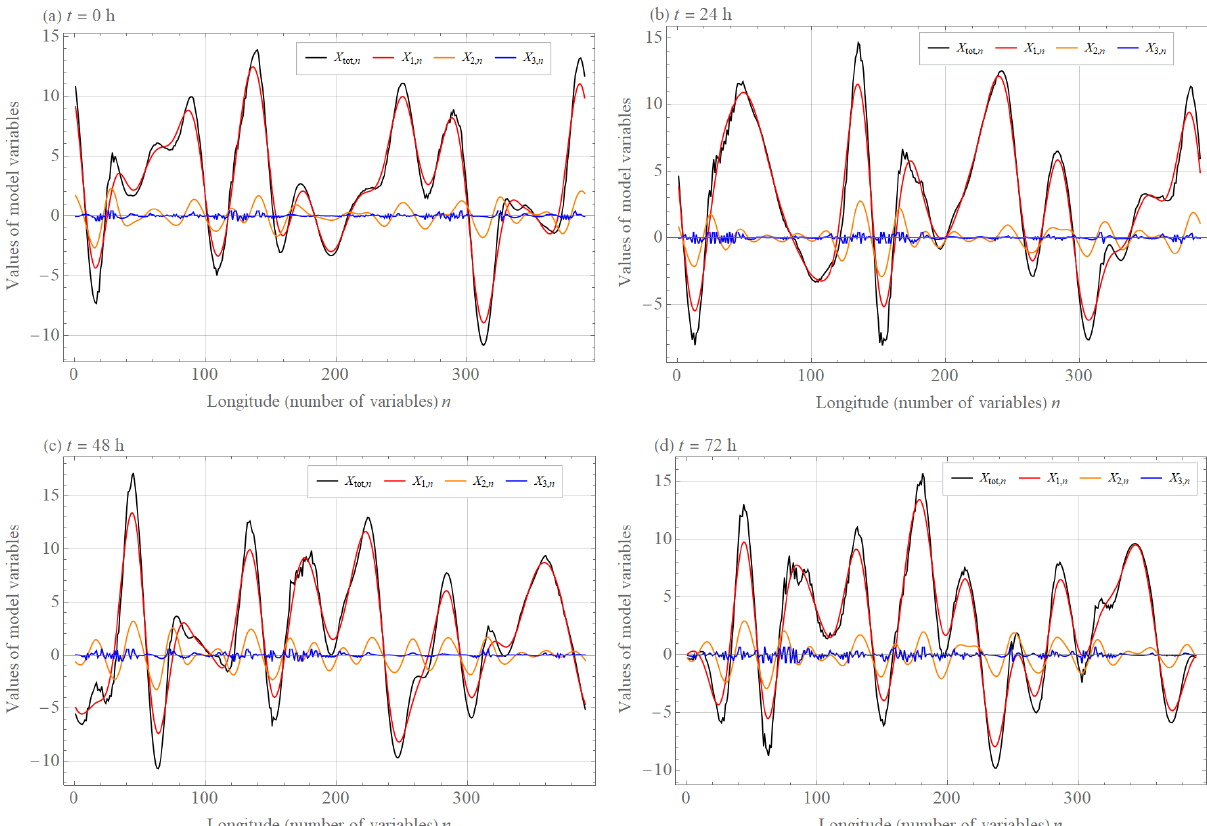
Figure 1. (a) Initial conditions (after discarding a transient of 10 years) and values of variables ( X tot ,X 1 ,X 2 ,X 3 ) at days (b) one, (c) two, and (d) three of the L05-3 system (Eqs. 13–15) with the parameters N = 390, L = 13, J = 6, F = 15, b 1 = 1, b 2 = 10, c 1 = 1, c 2 = 1, I 1 = 20, I 2 = 10 calculated by a fourth-order Runge–Kutta method with a time step (cid:49)t = 1 / 240 or 0.5h.